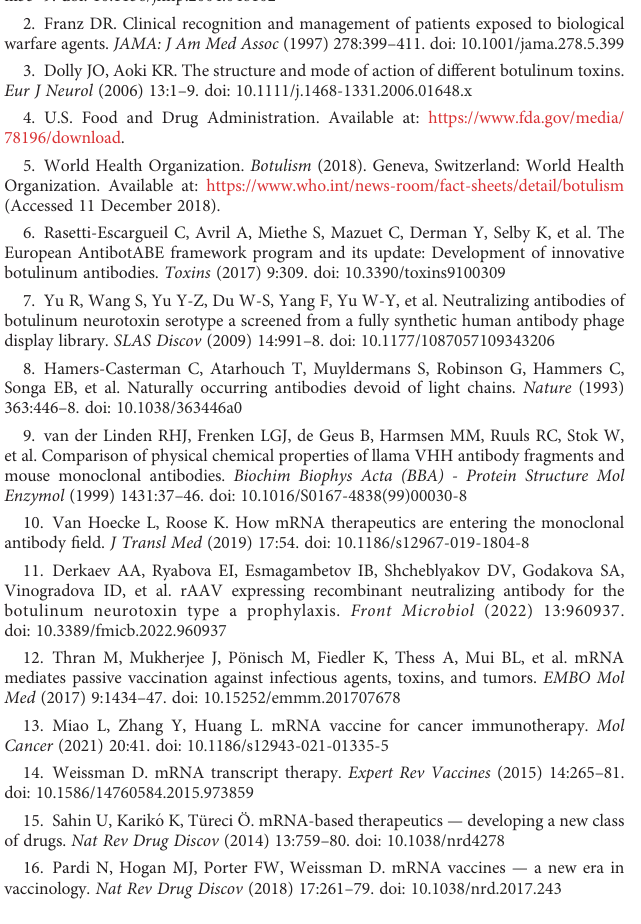
SUPPLEMENTARY TABLE 1 The primer sets used in the